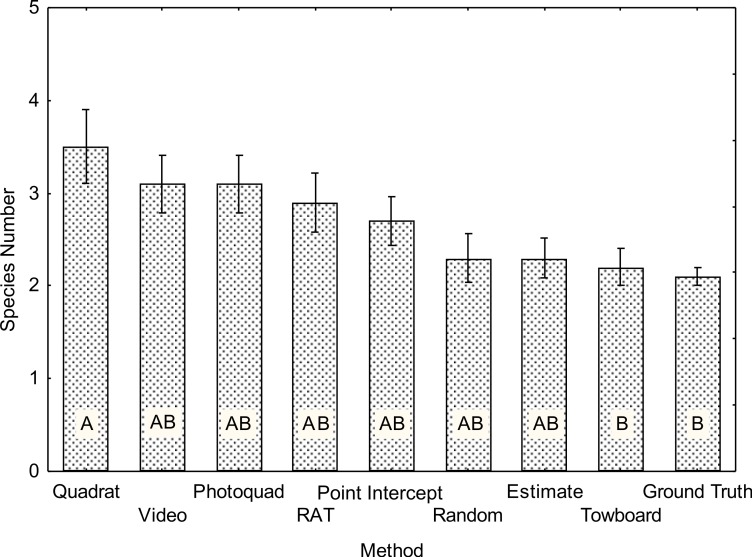
Average species count for each of the benthic survey methods (N = 10).Mean number ± 1 SE. The same letter denotes homogeneous means using a Tukey HSD post-hoc test on square root transformed data (F8,81 = 3.2 p = 0.003).